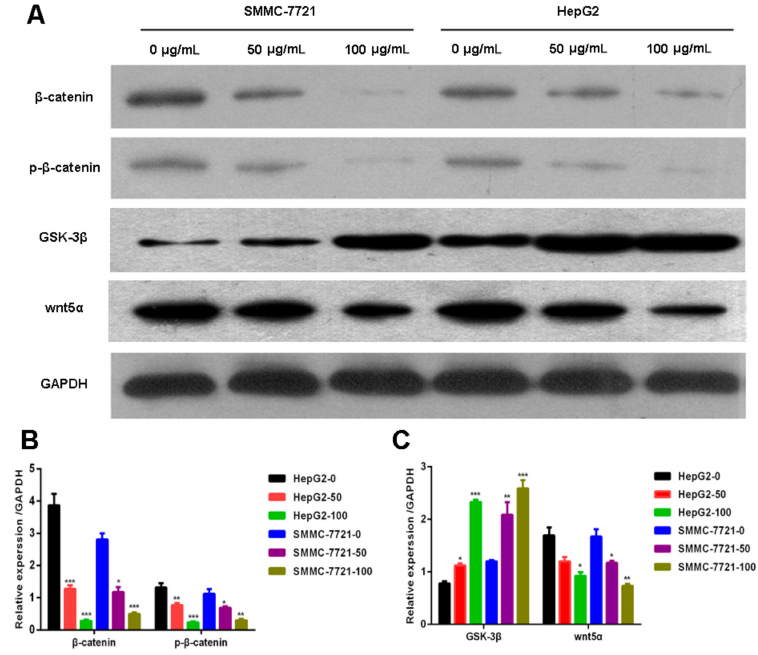
Figure 3. Daucosterol inhibited the expression of Wnt/ β -catenin signaling proteins in HepG2 and SMMC-7721 cells. HepG2 and SMMC-7721 cells were treated with 0, 50, and 100 µ g/mL daucosterol for 48 h. ( A ) Western blotting was performed to detect the levels of β -catenin, p- β -catenin, GSK-3 β , and Wnt5 α in treated HepG2 and SMMC-7721 cells. GAPDH was used as a protein loading control; ( B ) Daucosterol reduced β -catenin and p- β -catenin levels in HepG2 and SMMC-7721 cells (* p < 0.05, ** p < 0.01, *** p < 0.001); ( C ) Daucosterol inhibited GSK-3 β and Wnt5 α expression in HepG2 and SMMC-7721 cells (* p < 0.05, ** p < 0.01, *** p <